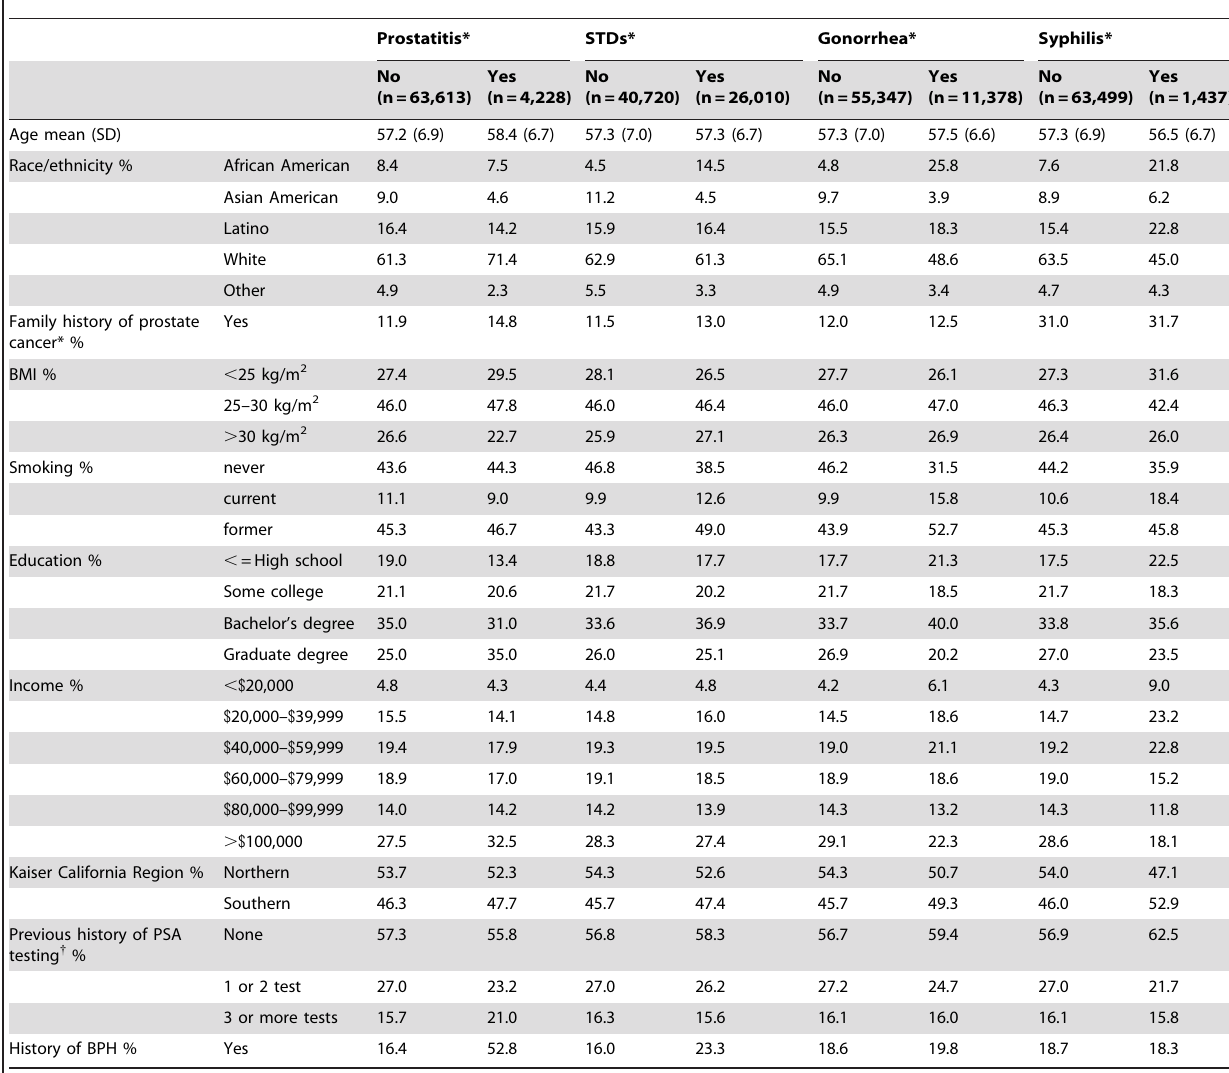
Table 1. Baseline charactersitics of men according to prostatitis and STD history, California Men’s Health Study, 2002–2006.